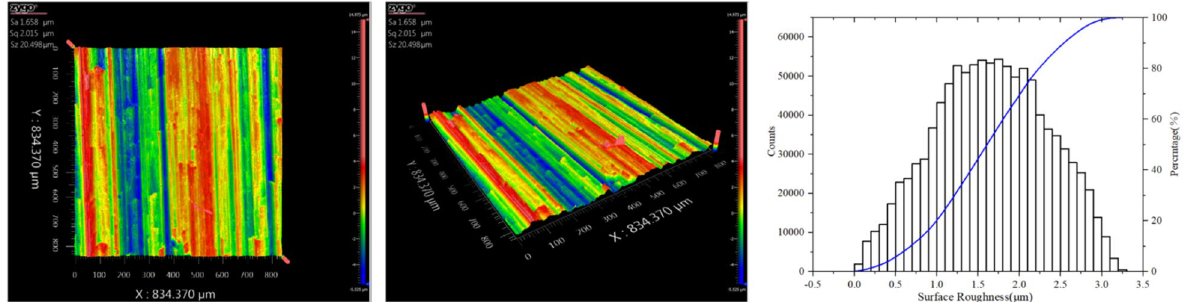
Figure 10 ( f 0.1 mm/r, v 200 m/min) 3D morphology, 2D morphology and roughness distribution curve of machined = =